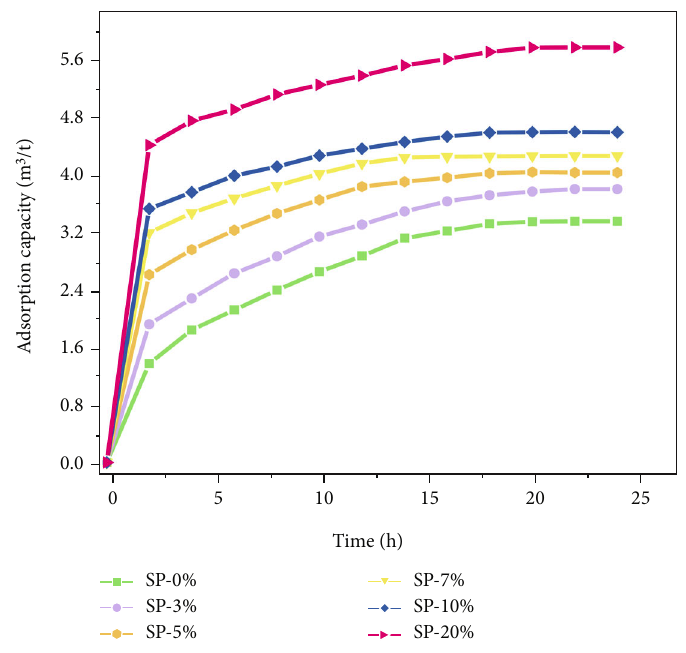
Figure 6: Curve of adsorption amount over time for coal samples having di ff erent water contents.